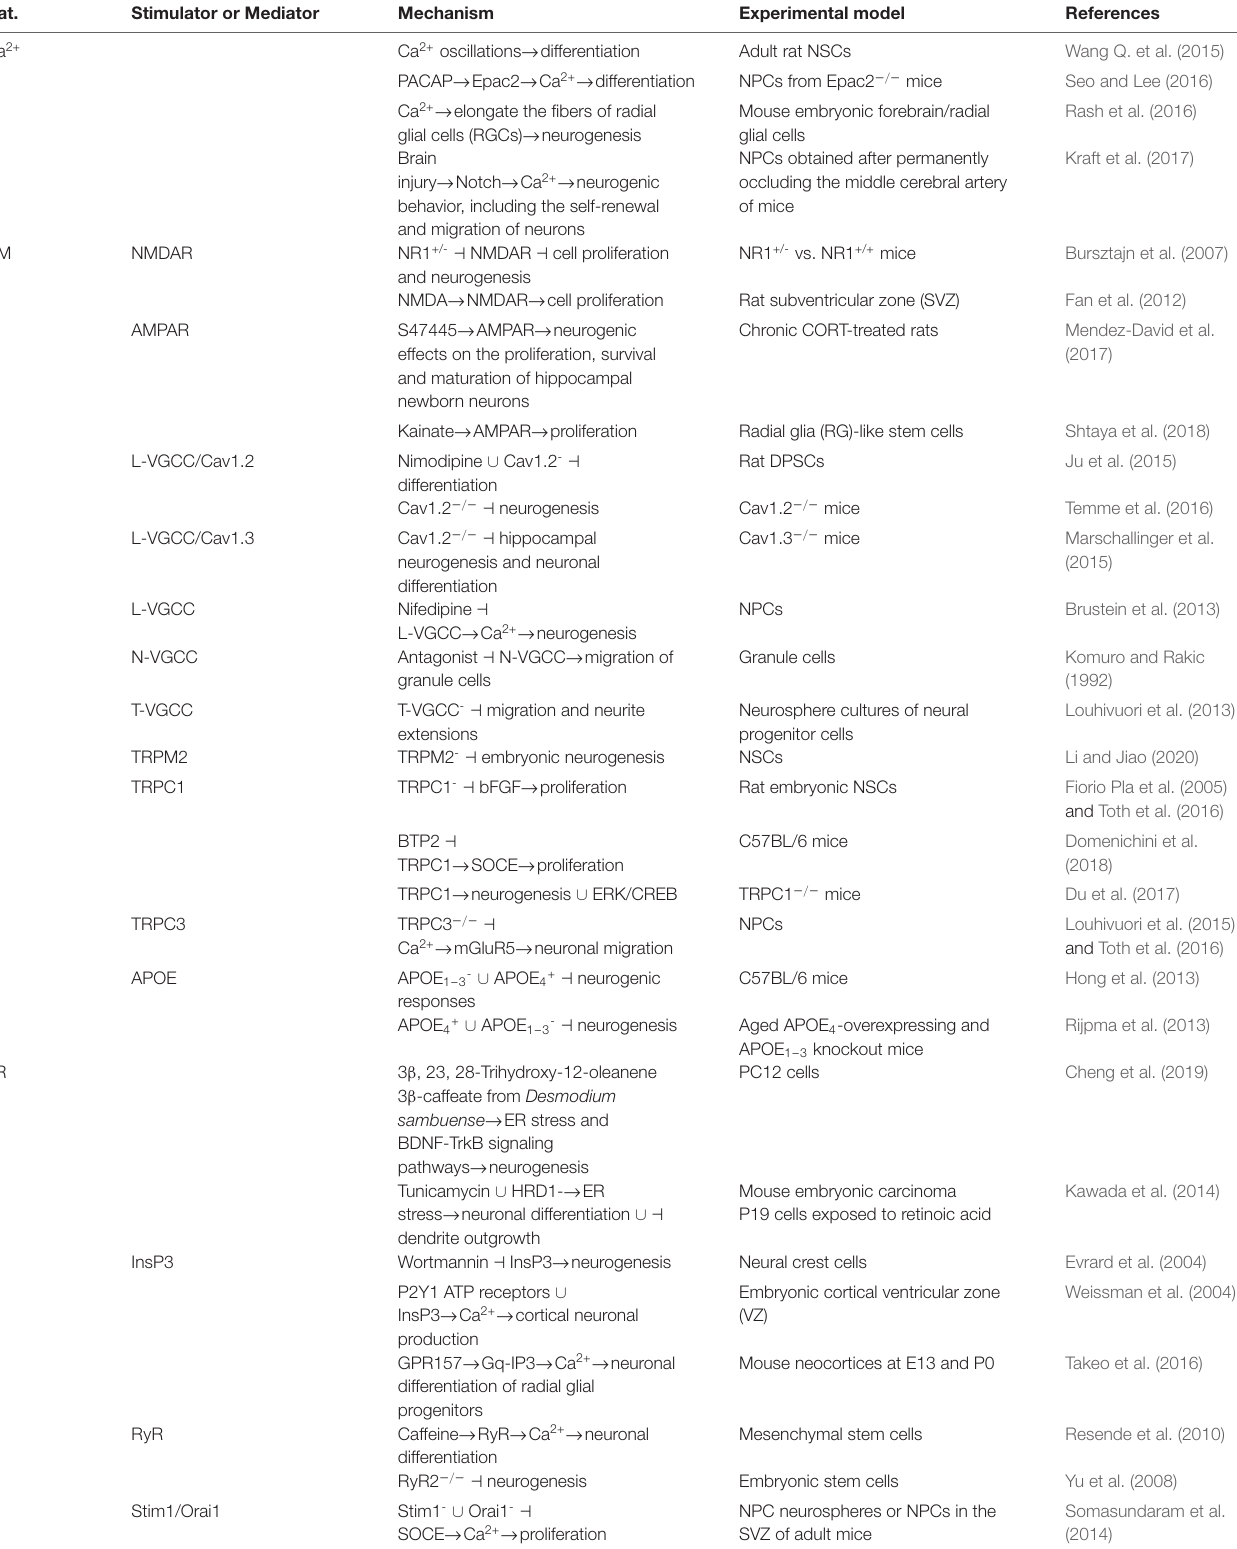
TABLE 3 | Ca 2+ regulates the neurogenesis of neuronal stem cells.